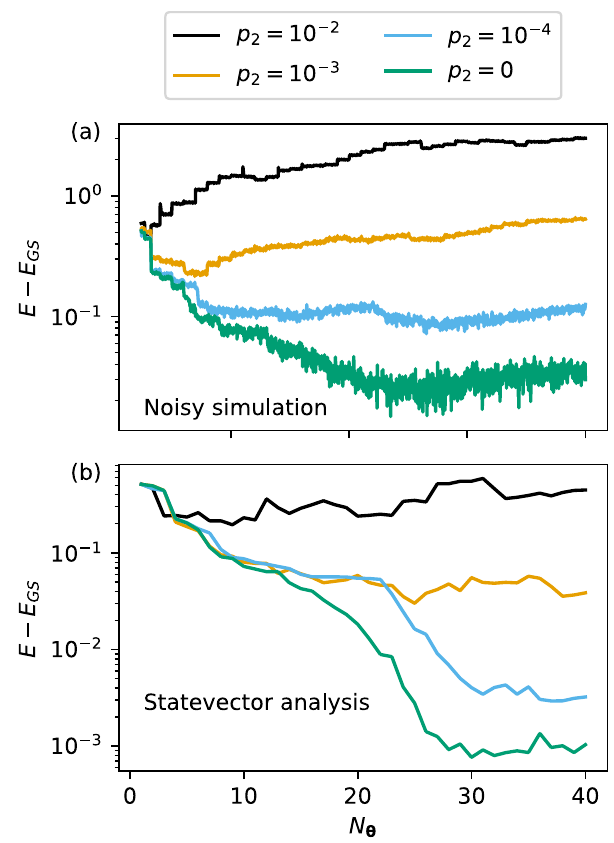
Fig. 7 Noisy qubit adaptive derivative-assembled pseudo-trotter (ADAPT) simulations and analysis of e g model. a Difference between the exact ground state energy E GS and qubit-ADAPT noisy simulation results with a uniform two-qubit gate error rate p 2 = 10 − 1 (black line), 10 − 3 (orange line), 10 − 4 (sky blue line) and 0 (bluish green line). We use a uniform single-qubit error rate p 1 = 10 − 4 and N sh = 2 16 shots per measurement circuit. b Energy differences evaluated using statevector for the adaptive ansätze obtained in the noisy simulations. The noisy simulations are performed with the Hamiltonian commutator pool of size